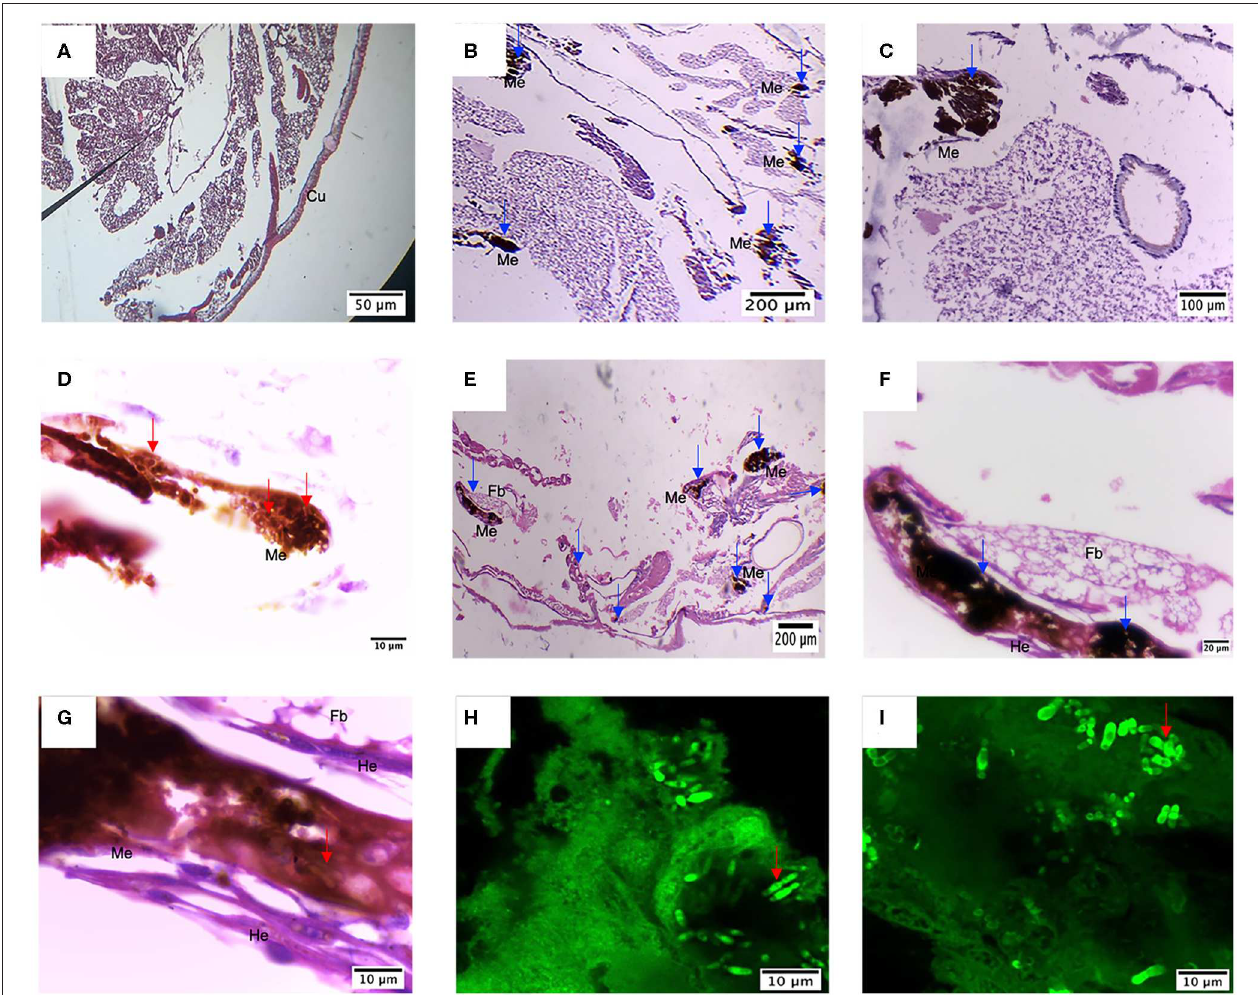
FIGURE 8 | Histology of G. mellonella infected with M. furfur and M. pachydermatis . (A) Control larvae display high tissue integrity and no sign of nodule formation, different from this (B–D) larvae infected with M. furfur presented different size nodules with melanin deposition and recruitment of new hemocytes; this is similar to what happens to (E–G) larvae infected with M. pachydermatis , which present different nodule formation with hemocytes recruited around it and proximity to fat bodies. Red arrows point to the presence of M. furfur and M pachydermatis yeasts; blue arrows indicate the presence of nodules. Dissected nodules stained with Calcofluor white confirm infection by (H) M. furfur and (I) M. pachydermatis . Fb, fat bodies; He, hemocytes; Me, Melanin